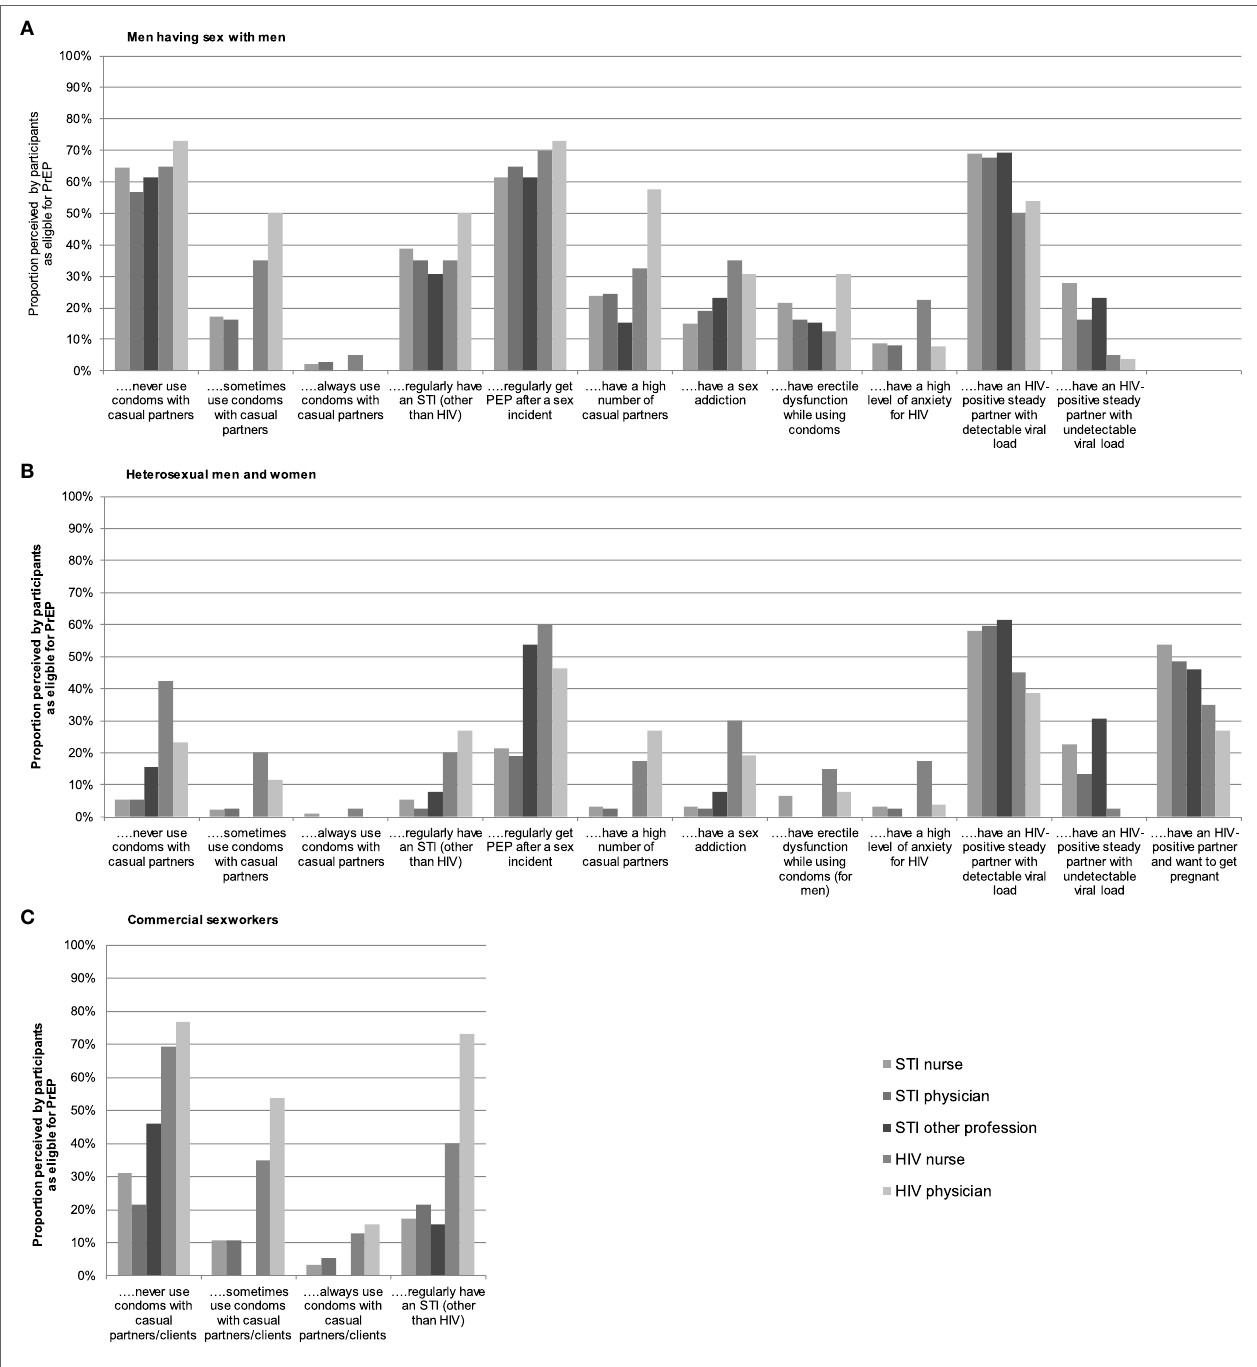
FigUre 2 | Beliefs among health-care professionals as to which key populations are eligible for pre-exposure prophylaxis (PrEP) in the Netherlands: (a) men having sex with men, (B) heterosexual men and women, and (c) commercial sex